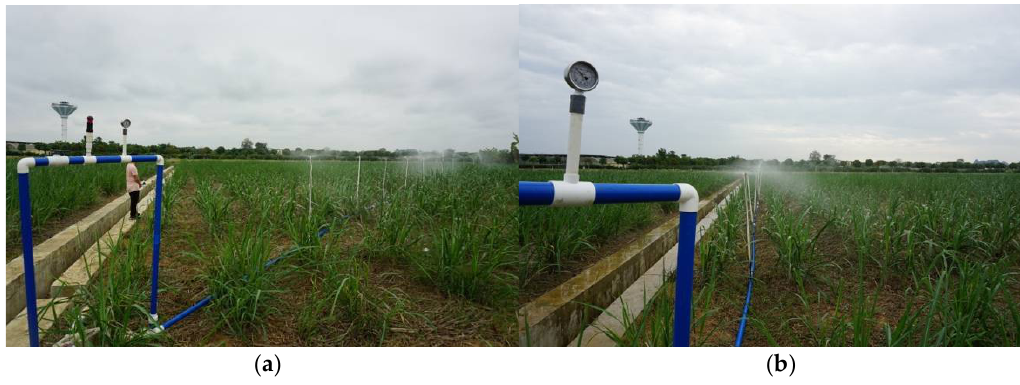
Figure 3. ( a , b ) CHL irrigation system working in two different positions.